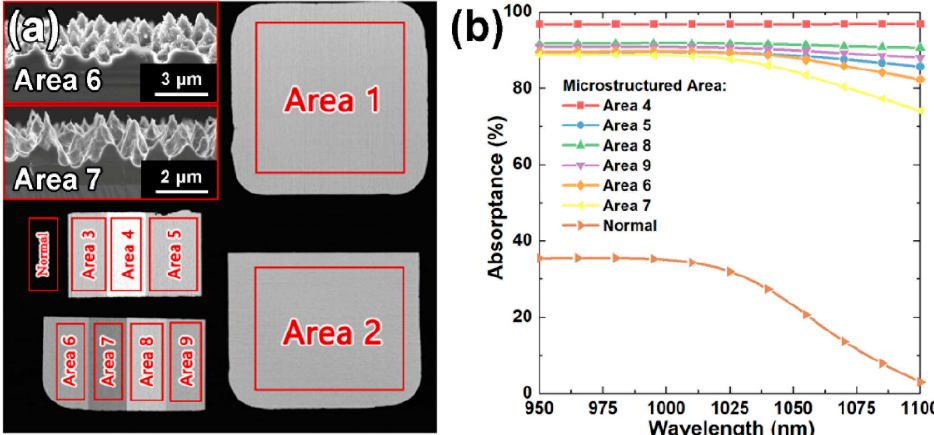
Figure 2. ( a ) Gray value measurements of microstructured areas (irradiated with different laser fluences) and unprocessed area of CMOS image sensor at an integration time of 82 ms. The size of the photosensitive surface of the sensor is 22.5 × 22.5 mm. Inset: Side view SEM images of Area 6 and Area 7. ( b ) NIR absorption spectra of microstructured areas of CMOS image sensor. The NIR absorptance of an untreated normal area of CMOS image sensor is included for comparison.